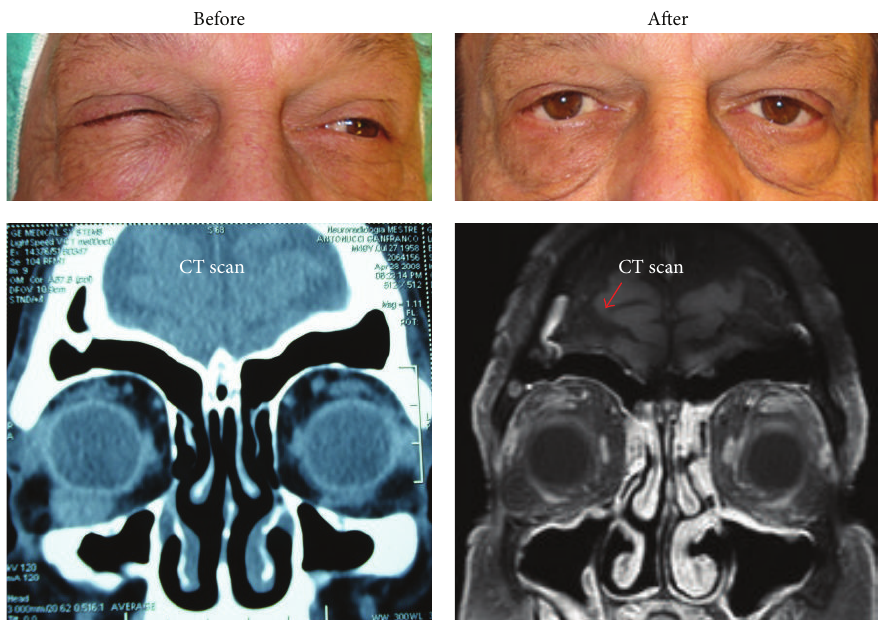
Figure 1: GCT before and after surgery. Top panel shows proptosis before (left) and after (right) surgery. Bottom panel shows CT scans to identify the GCT (left), and to confirm the absence of the mass after surgery (right).